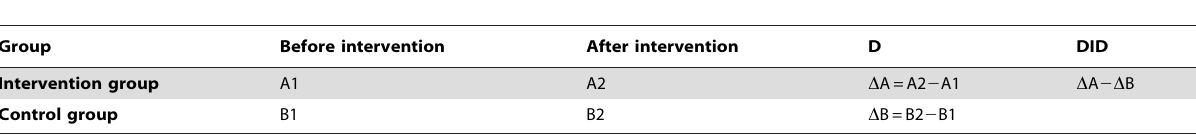
Table 1. Design of the difference-in-difference